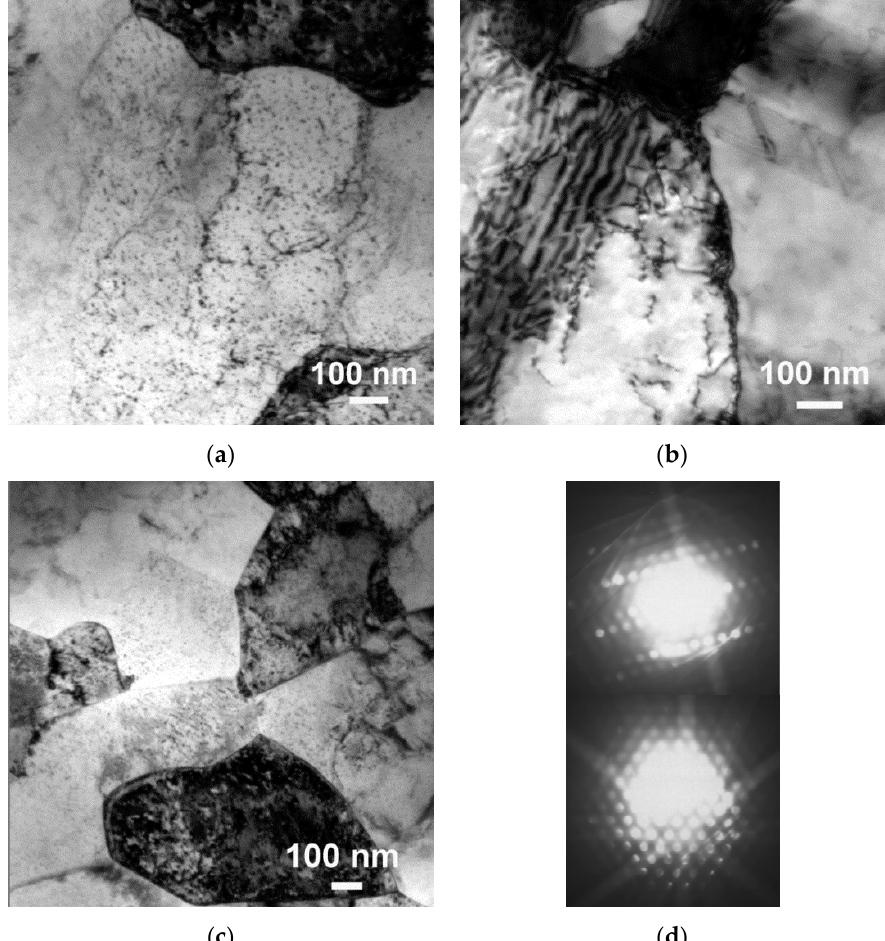
Figure 2. Microstructure evolution with cumulative HPT shear strain of OFHC 99.99% pure Cu at ε eq = 0.40 ( a ); ε eq = 0.91 ( b ); and ε eq = 1.21 ( c ). A representative Kikuchi pattern used to measuring the misorientation across the boundaries is reported in ( d ), in the case of OFHC 99.99% pure Cu at ε eq =